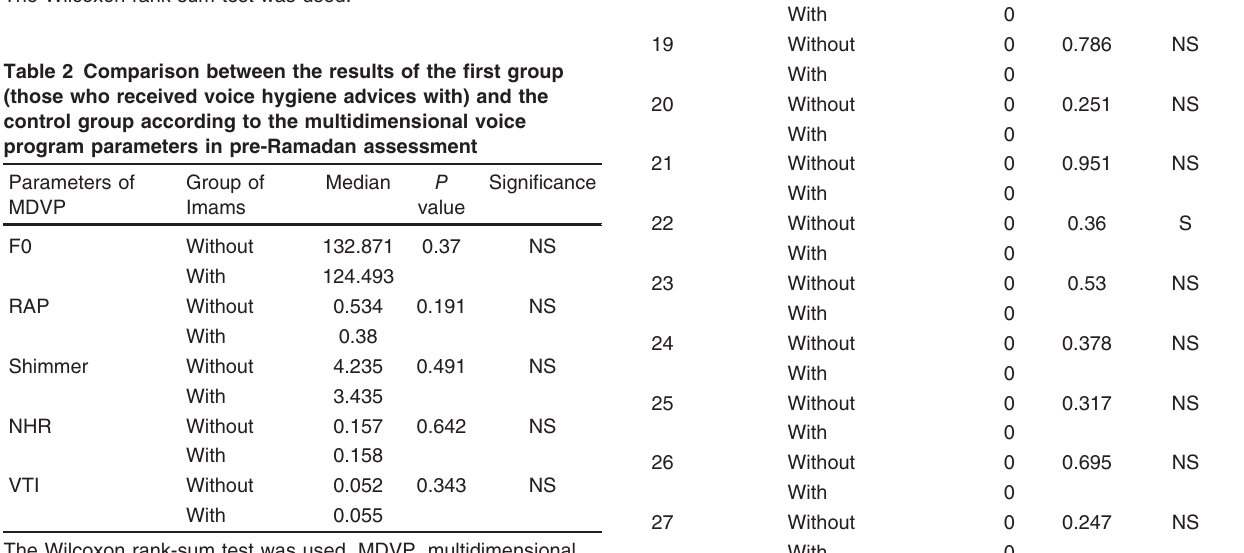
The Wilcoxon rank-sum test was used. MDVP, multidimensional voice program; NHR, noise-to-harmonic ratio; RAP, relative average perturbation.